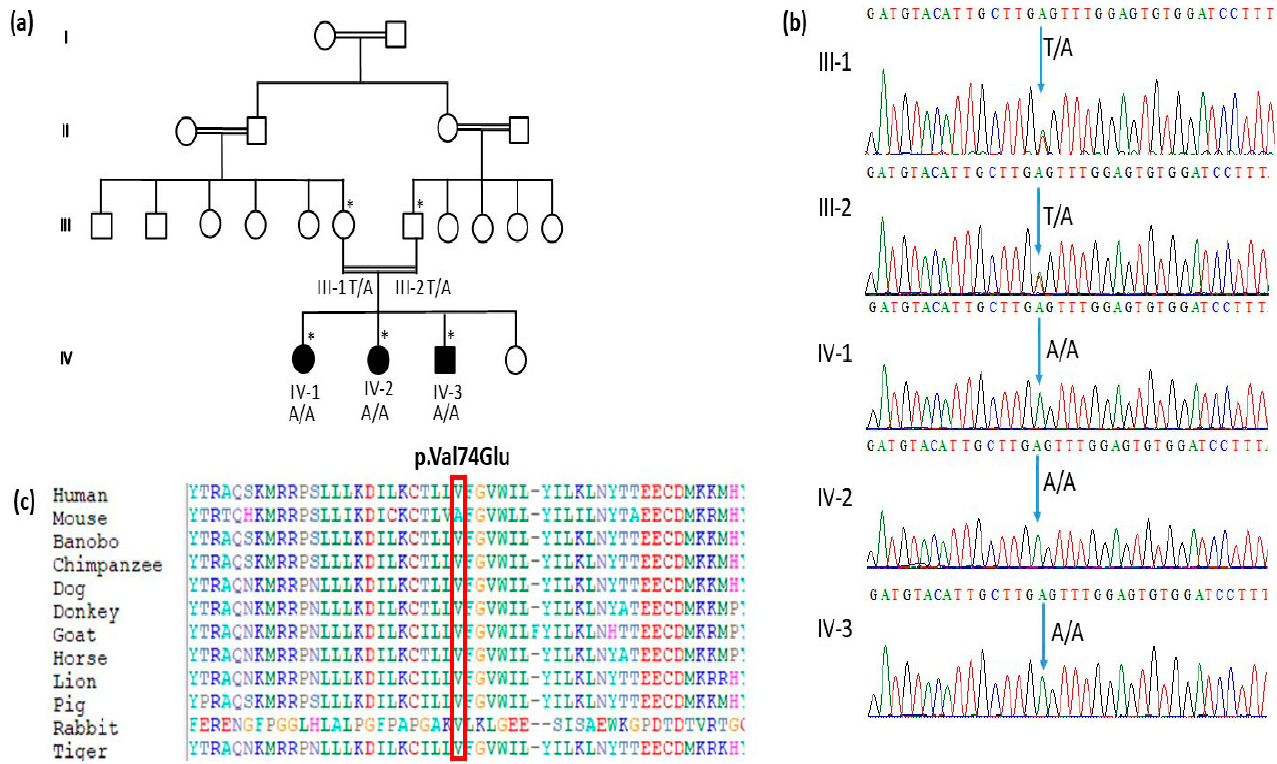
Figure 1. ( a ): Pedigree of the family members showing the details. (*) represent the samples available for the study. ( b ): Representative electropherogram of ST3GAL5 gene. Sanger sequencing results showing that all three affected IV-1, IV-2, and IV-3 members had T/T on both alleles while the parents III-1 and III-2 were heterozygous carriers A/T at the same position of the ST3GAL5 gene. ( c ): Protein alignment showed highly conserved amino acids between different species. Figure showing the conserved amino acid p.Val74Glu in ST3GAL5 highlighted in all species.